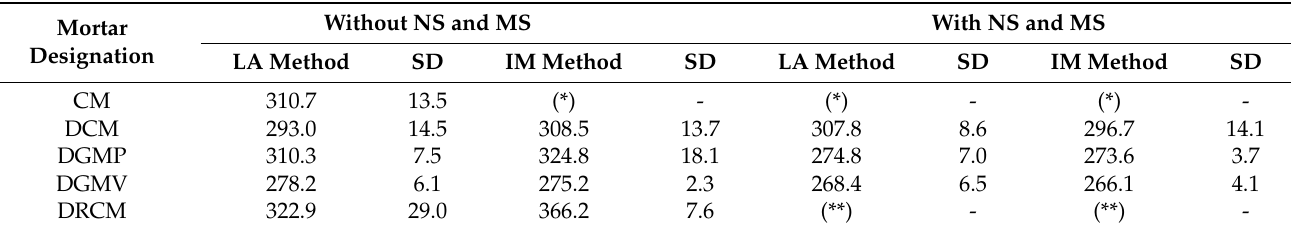
Table 5. Average values and corresponding standard deviation of the maximum temperature ( ◦ C) on the inner surface of the specimen’s steel